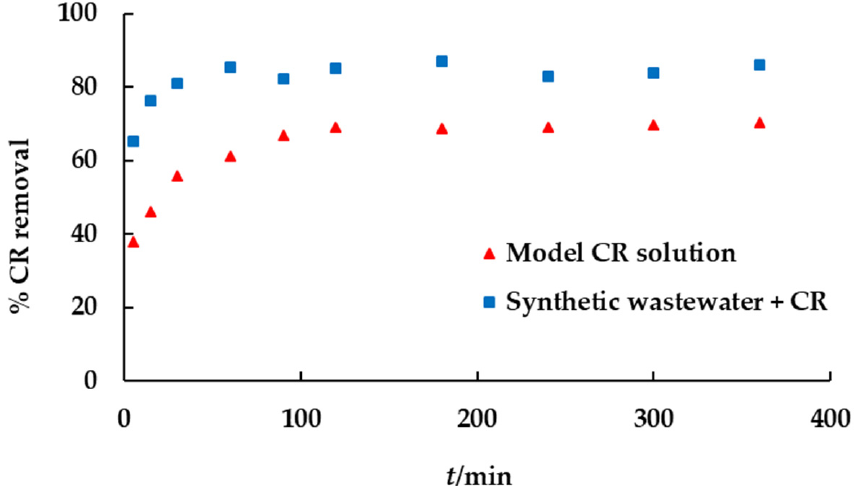
Figure 9. Biosorption of CR to EP from model CR solution and synthetic wastewater with the addition of CR ( γ CR = 50 mg dm − 3 , γ biosorbent = 8 mg dm − 3 , t =360 min, T = 298.15 K, v = 150 rpm).